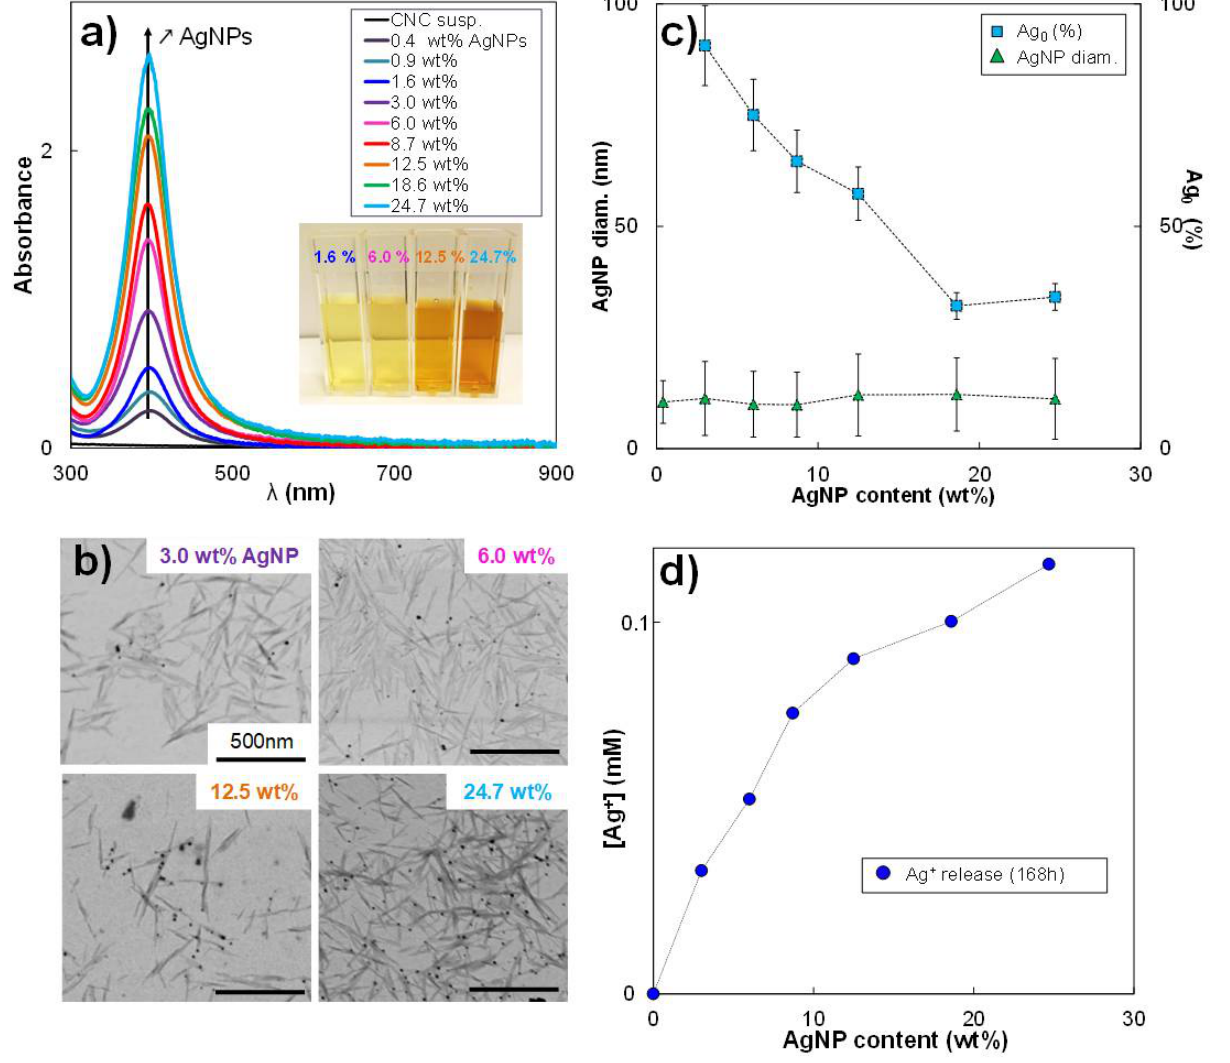
Figure 1. ( a ) UV/vis spectra and ( b ) STEM images of CNC/AgNP hybrids at various AgNP contents; ( c ) Evolution of AgNP average diameter and Ag 0 fraction in AgNPs as a function of the AgNP content in the hybrid suspension; ( d ) Ag + release plateau value at 168 h in pure water.